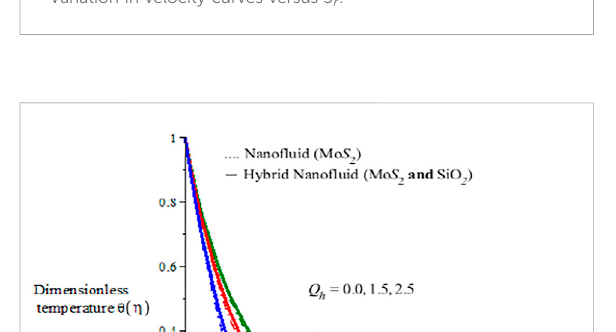
FIGURE 5 Variation in velocity curves versus S r .